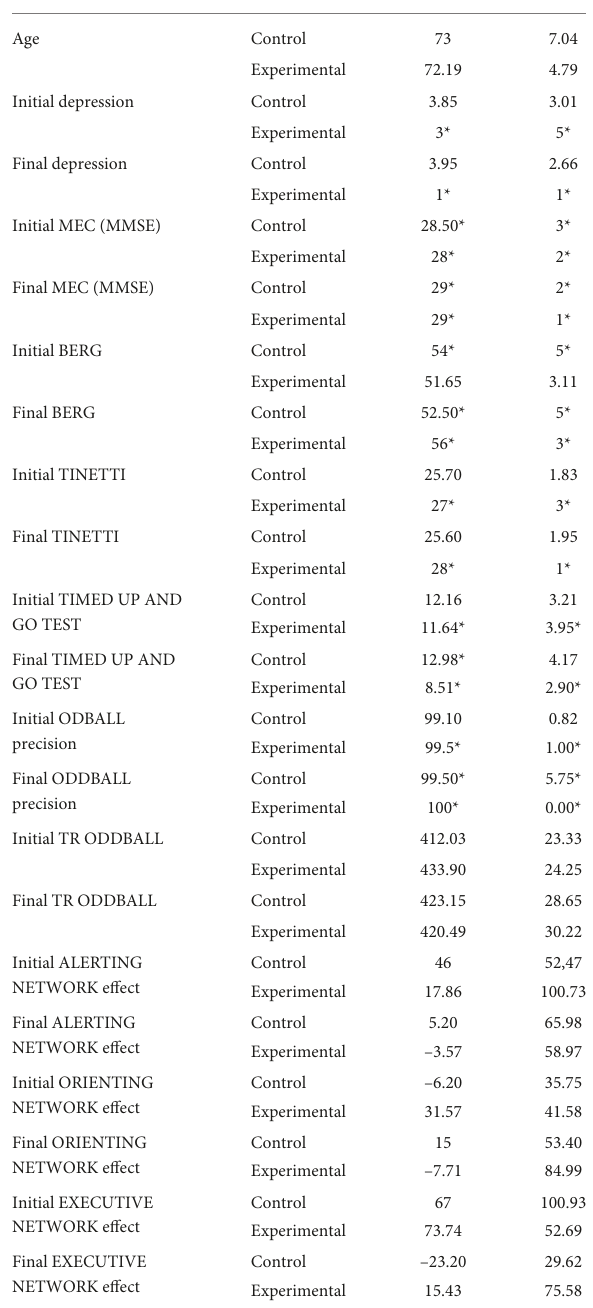
FIGURE2 Flowchart. Consort